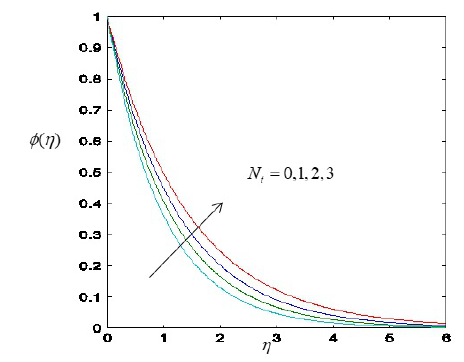
Fig. 14: Influence of Lewis number Le on ϕ ( η )